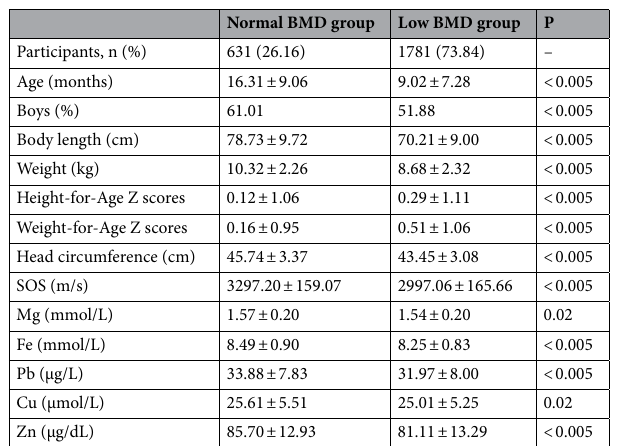
Table 1. Participant characteristics. Categorical variables are shown as average (percentage). Continuous variables are shown as mean ± standard deviation. n number, BMD bone mineral density, SOS speed of sound, Mg magnesium, Fe iron, Pb lead, Cu copper, Zn zinc.